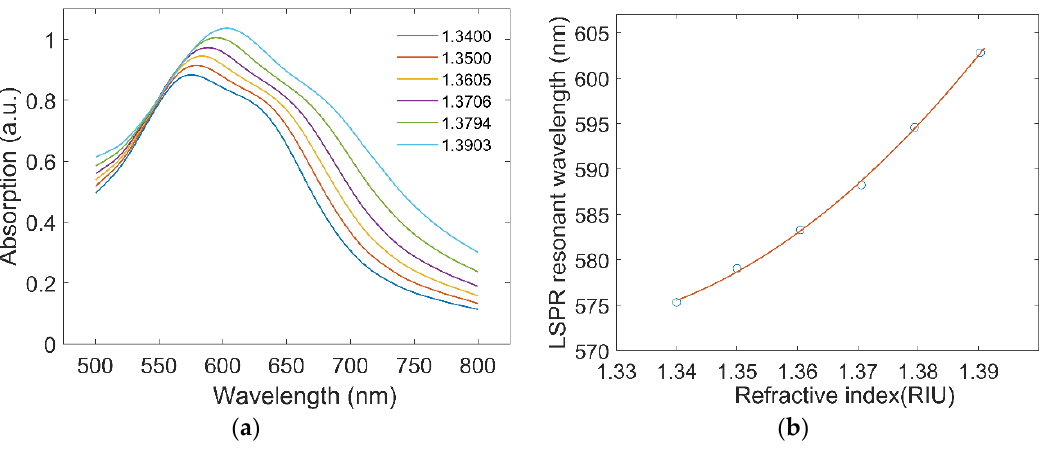
Figure 5. Refractive index sensing based on the proposed LSPR sensor. ( a ) Absorption spectra of different concentrations of sucrose solution; ( b ) LSPR resonant wavelength as a function of the refractive index of the sucrose solutions.